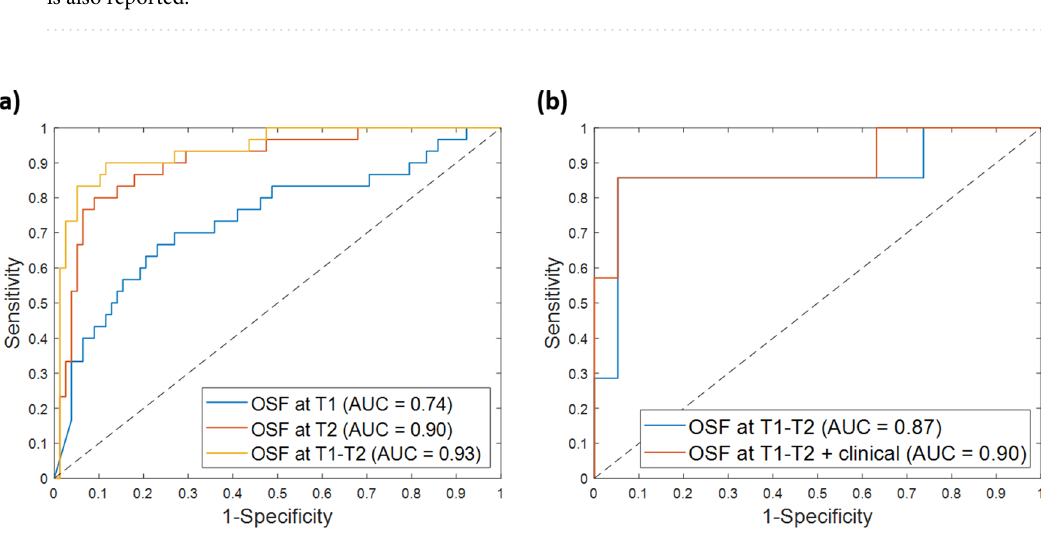
Table 2. Summary of the performances of the pCR prediction models in terms of accuracy, sensitivity, and specificity on the fine-tuning dataset and the independent test. The number of features composing each model is also reported.